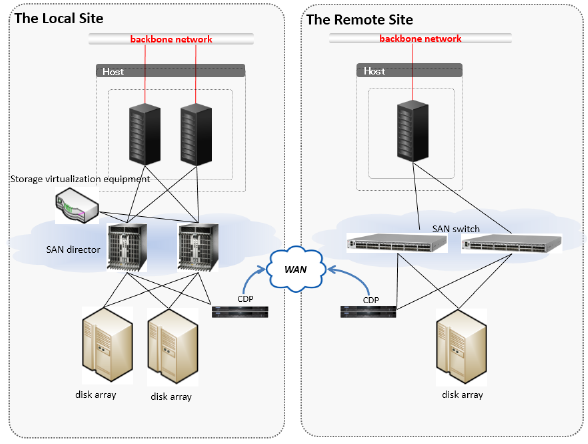
Figure 1. Data disaster recovery system